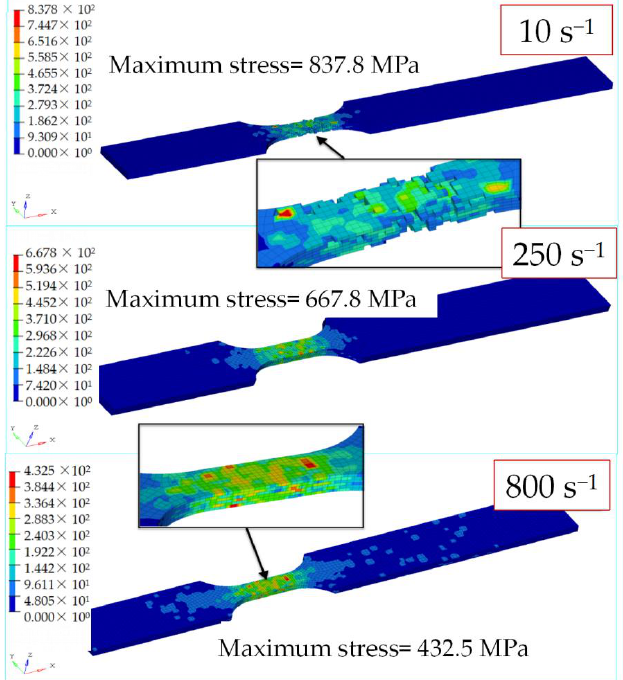
Figure 6. Stress contour map of [0/90/±45] 3s at different strain rates when d = 0.13 mm.